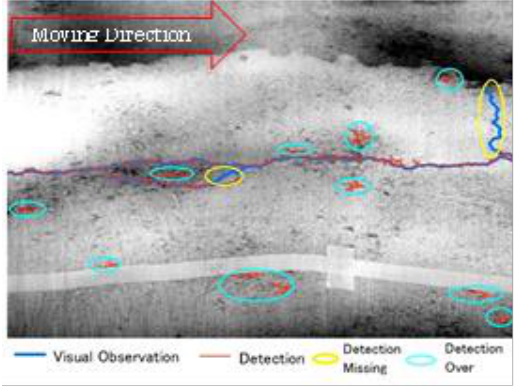
Figure 10. Results of the crack detection Visual Detection